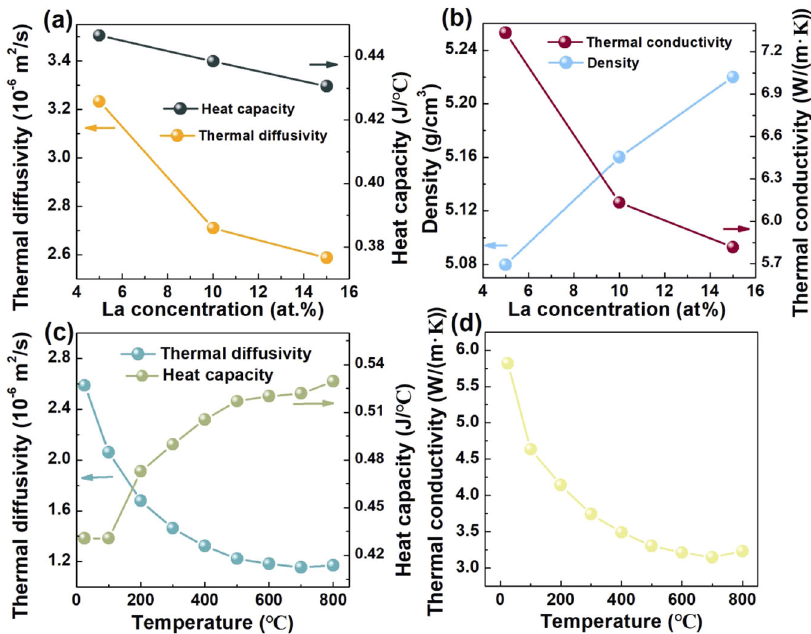
Fig. 6 (a) Thermal diffusivity and heat capacity, and (b) density and thermal conductivity as a function of La-doping concentration. (c) Thermal diffusivity and heat capacity, and (b) thermal conductivity of 15.0 at% La-doped Y 2 O 3 sample dependence on